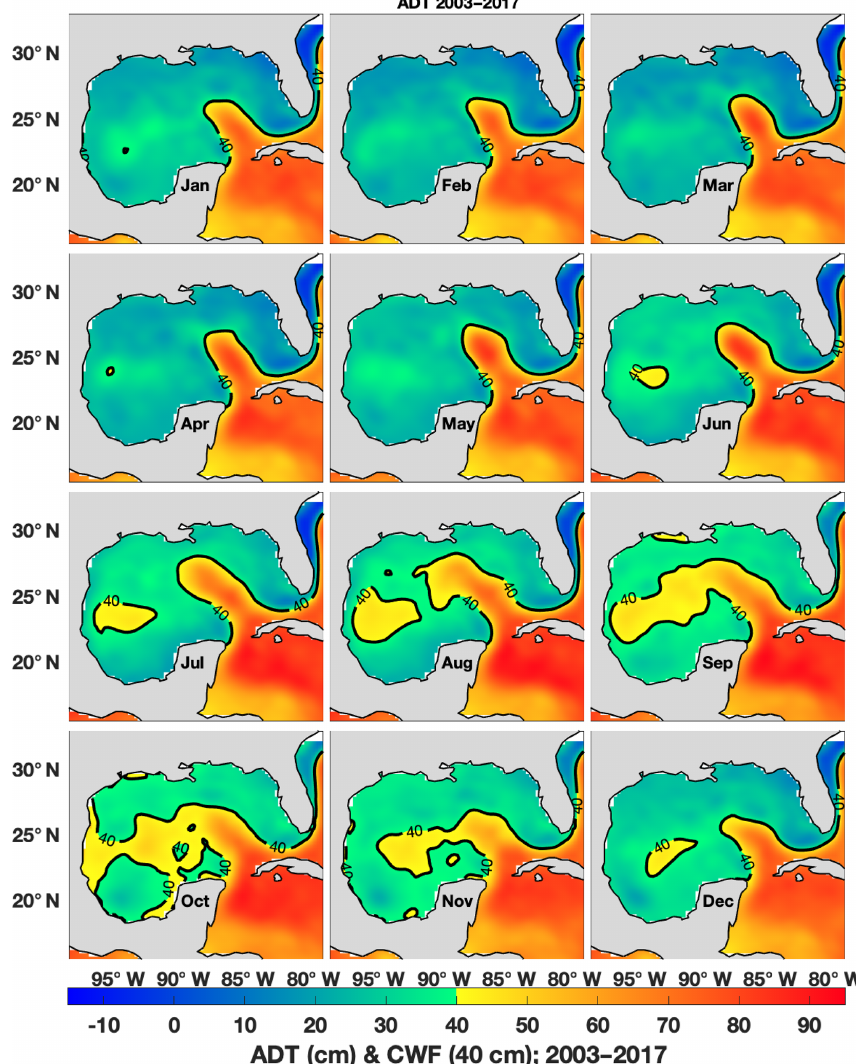
Figure 7. Monthly means of absolute dynamic topography (ADT) from 2003 to 2017 (color) and the respective CWF computed with the 40cm isoline (heavy black